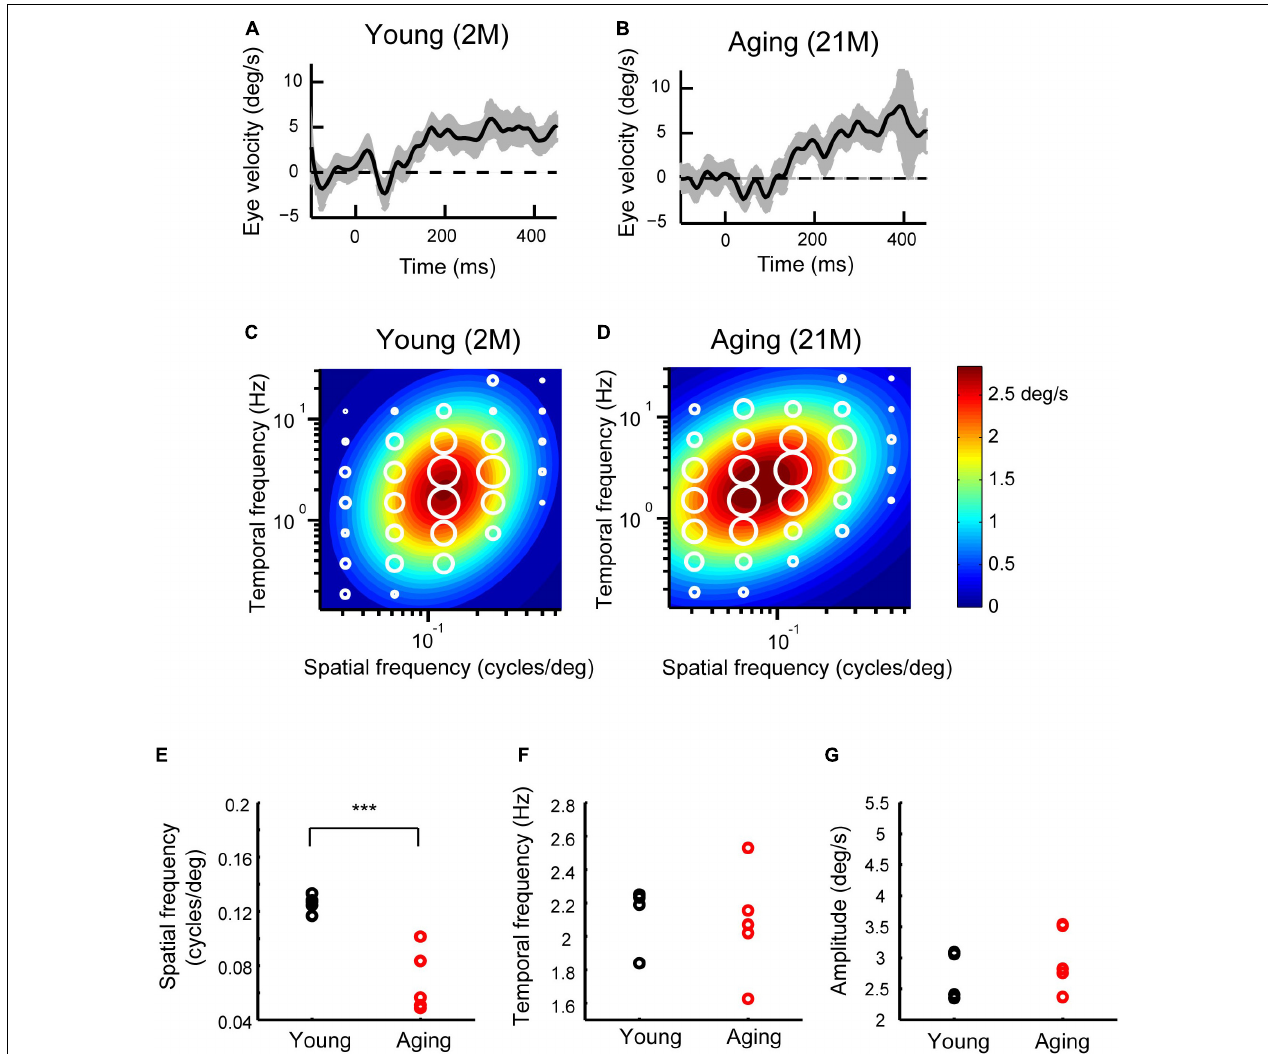
FIGURE 5 | Initial OKRs in the young adult and normal aging mice. (A,B) Eye velocity profiles obtained from a young adult mouse (A) and an aging mouse (B) . The eye movements evoked by the visual stimuli of SF = 0.125 cycles/deg; TF = 1.5 Hz. The gray shaded areas indicate the standard deviation of the individual eye velocity ( A: 23 trials, B: 27 trials). (C,D) Heat maps of the initial OKRs in the young adult mice (2–3 months old, n = 5) (C) and normal aging mice (21–24 months old, n = 5) (D) . Amplitudes of the initial OKRs represented by diameter of the white circles are plotted in the coordinate system of SF and TF. Heat maps indicate the best-fit Gaussian functions. (E–G) Comparisons of the properties of the initial OKRs. The differences in the optimal SF (E) , optimal TF (F) , and peak amplitudes of the responses (G) are shown individual plot (black dots: young adult, red dots: aging). *** p = 2.2 × 10 - 3 , Wilcoxon rank-sum